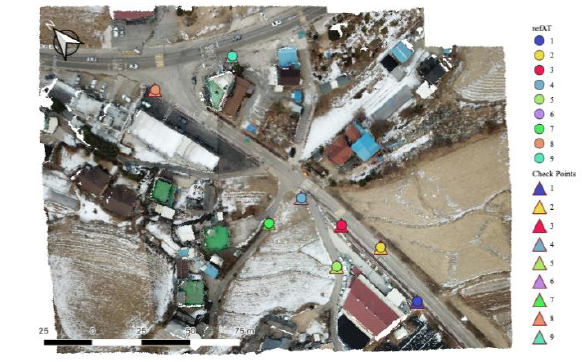
Figure 7. Check points and corresponding image points (refAT) Table 3 and table 4 describe the positional accuracy of DG and refAT respectively. The RMSE of refAT was smaller than DG.